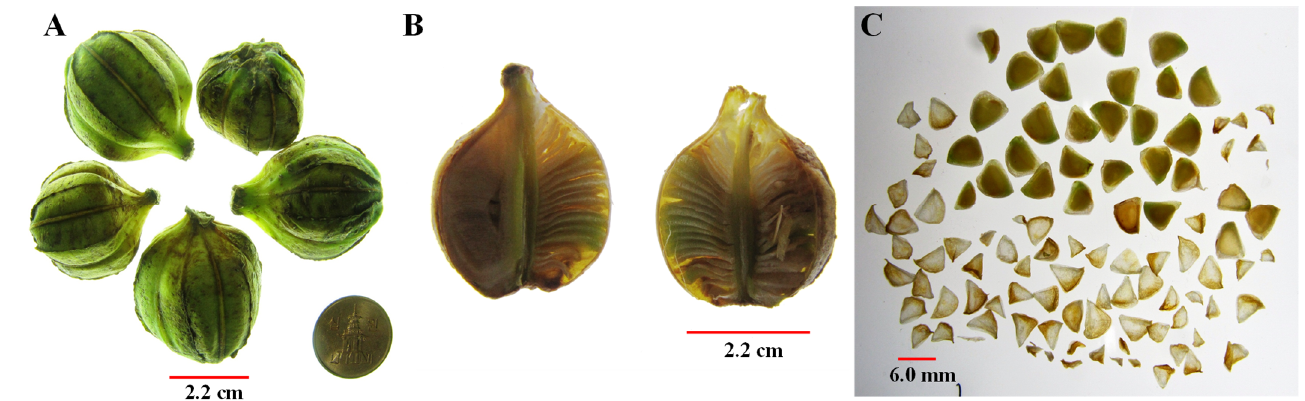
Table 1. Summary of interspecific crossing between L. hansonii and L. brownii var. colchesteri.